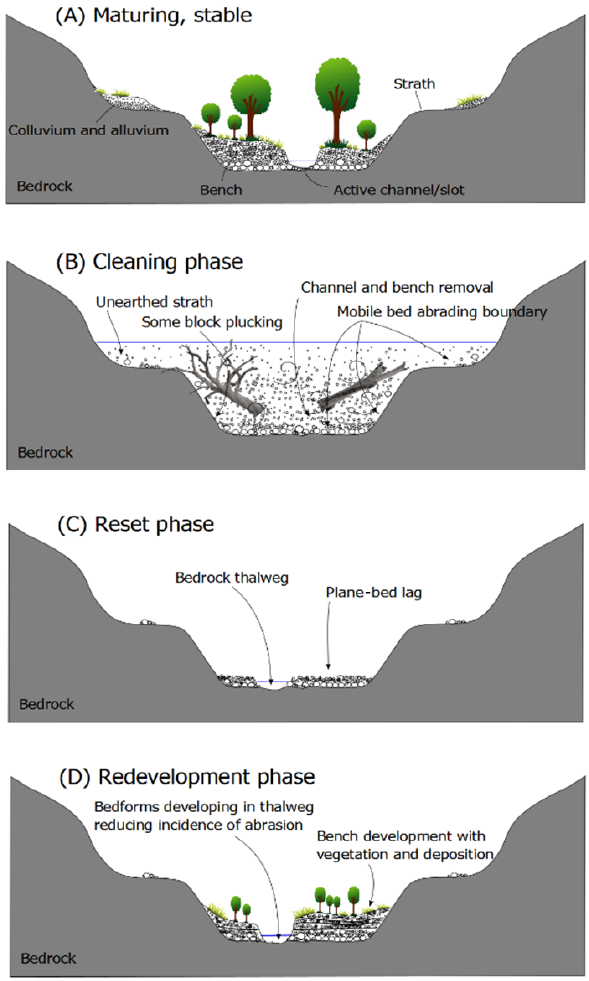
Figure 8. Schematic model for the evolution of semi-alluvial chan- nels to an extreme